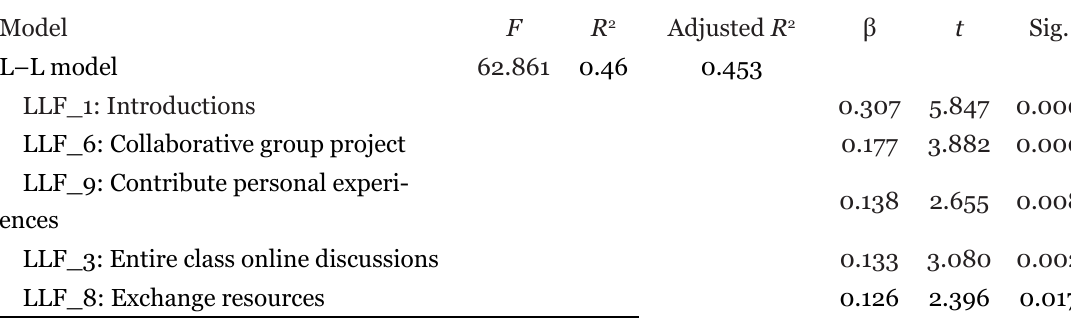
Significance of the Regression Model and Regression Coefficients for Significant Predictors in Learner–Learner